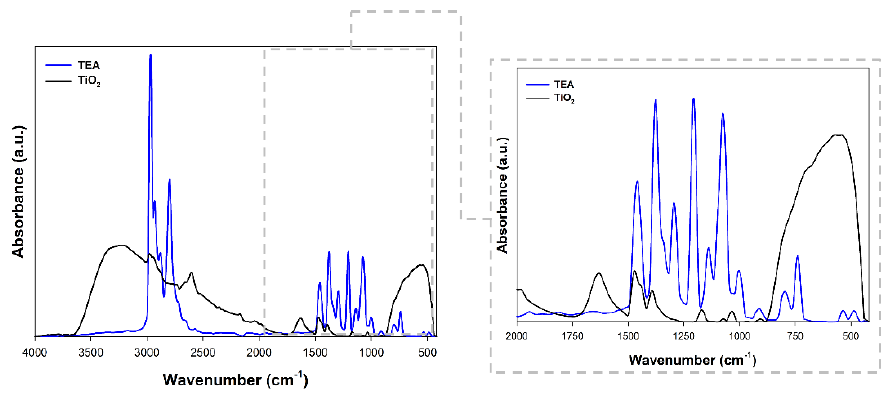
Figure 3. FTIR spectra for triethylamine (TEA) and TiO 2 modified with TEA.